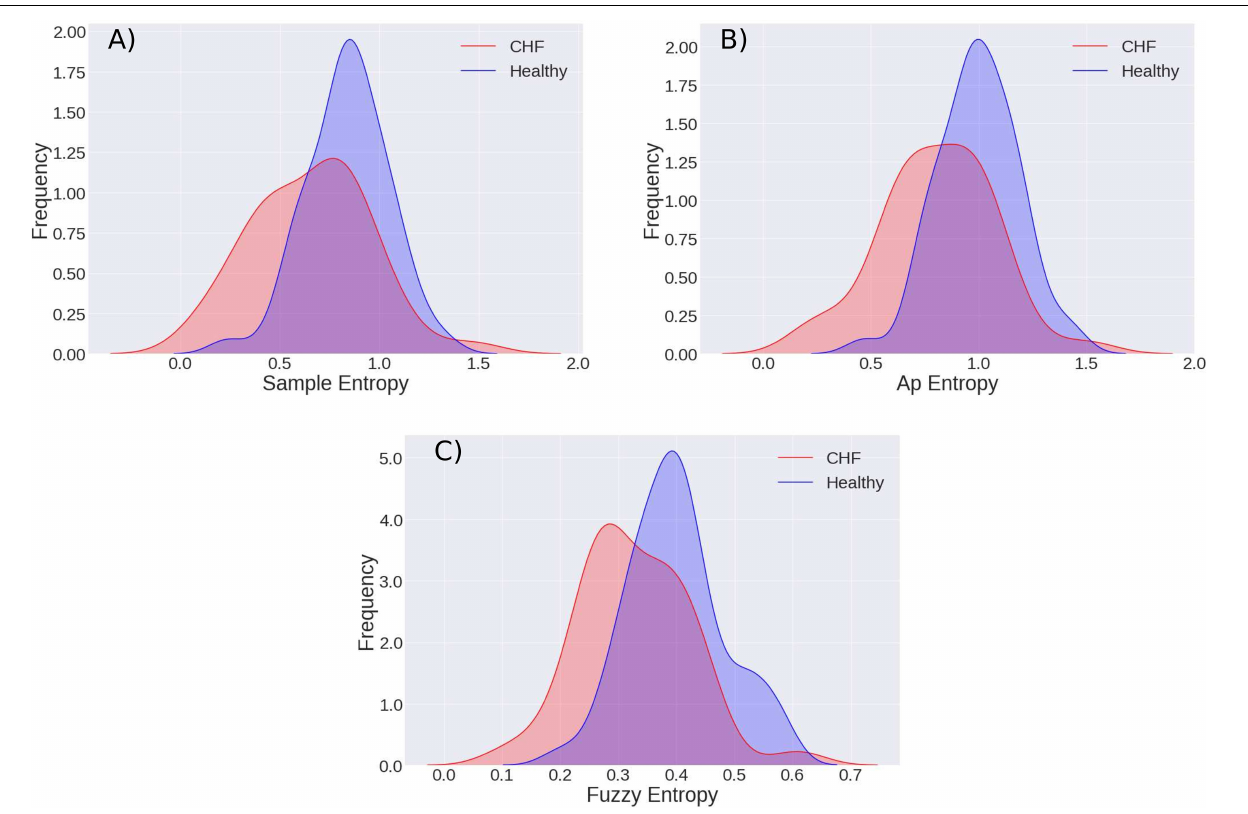
FIGURE 2 | Entropy comparison of the asleep period time series of the 39 congestive patients and 52 healthy subjects. The time series correspond to the 6-h records while the subjects are asleep. (A) Sample Entropy. (B) Approximate Entropy. (C) Fuzzy